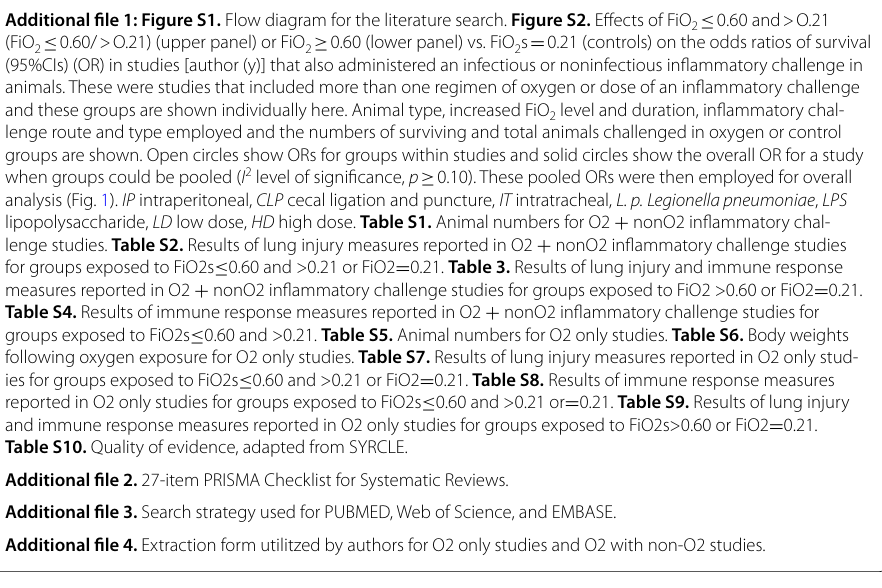
Table S10. Quality of evidence, adapted from